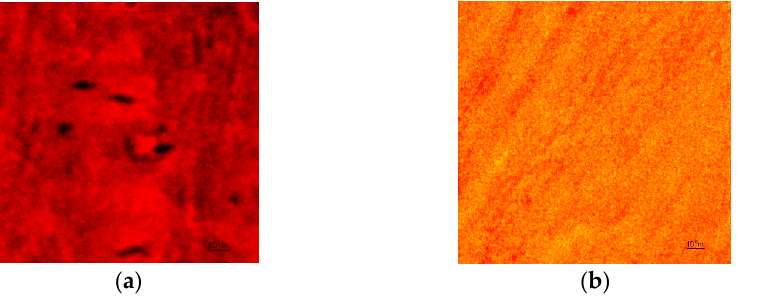
Figure 4. Micrographs of the film with a coating formed by a composition of PTFE and stabilized magnetite: ( a ) without US treatment; ( b ) after US treatment. Optical microscopy method. The magnification is 1000 times.